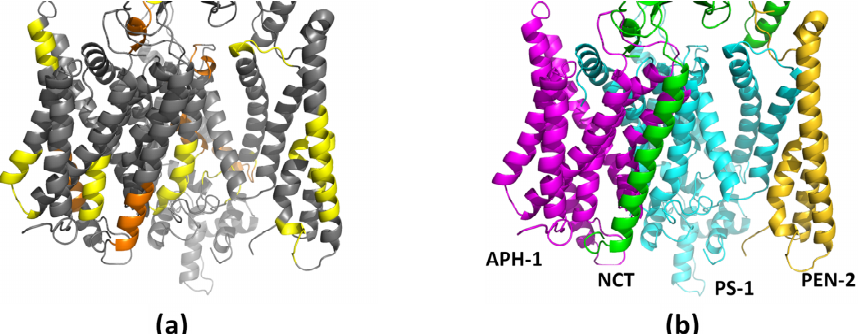
Figure 8. Location of the cholesterol binding motifs in γ -secretase. Only the membranous part of the complex is shown. ( a ) The cholesterol binding motifs CRAC (orange) and CARC (yellow); ( b ) the same orientation of γ -secretase with colored subunits is shown as a reference structure. The scheme of colors is the same as in Figure 2.